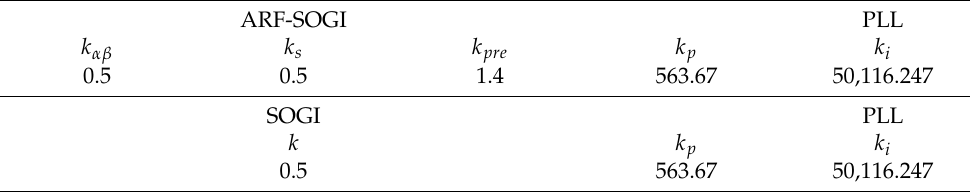
Table 2. Gains for tuning set S2 (small SOGI bandwidth, large PLL bandwidth).